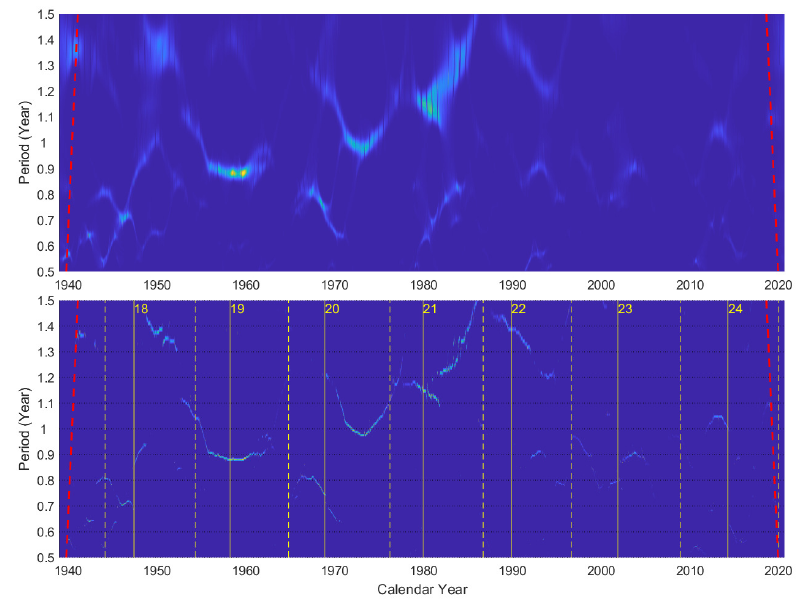
Figure 11. Same as Figure 6, but for periods between 0.5 and